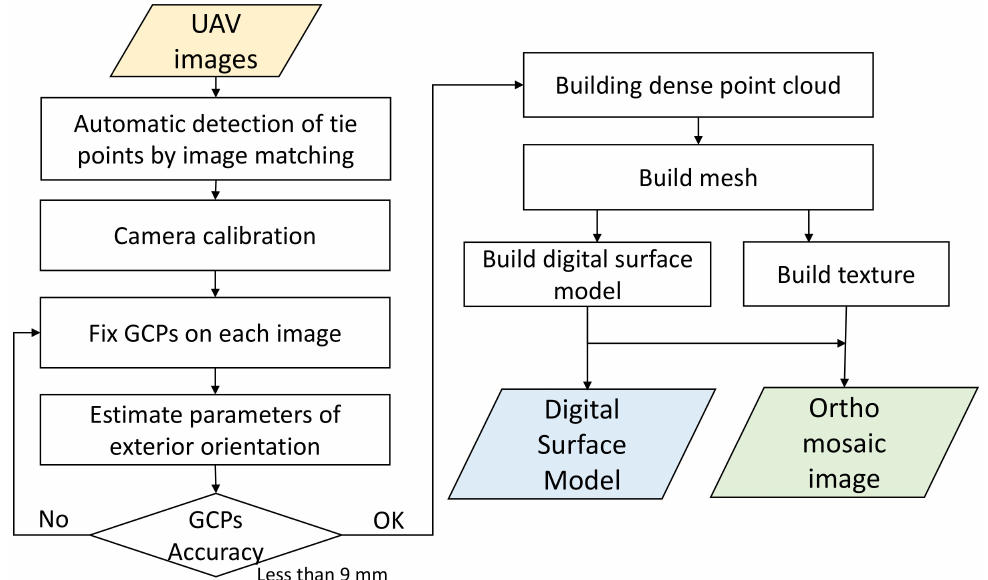
Figure 3. The flowchart of generation of the digital surface model and ortho mosaic image from UAV